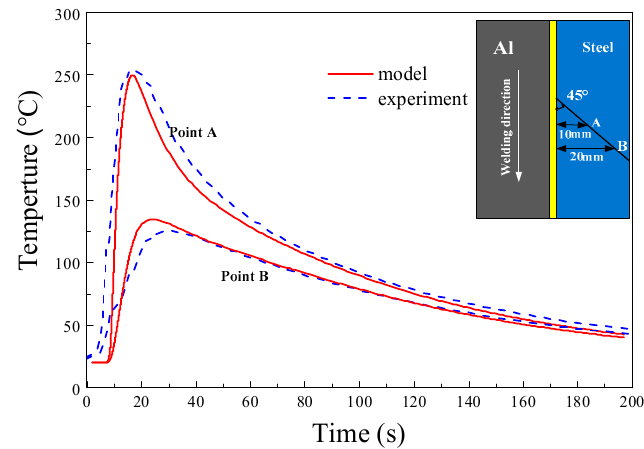
Figure 5. Comparison between experimental and calculated thermal cycles.